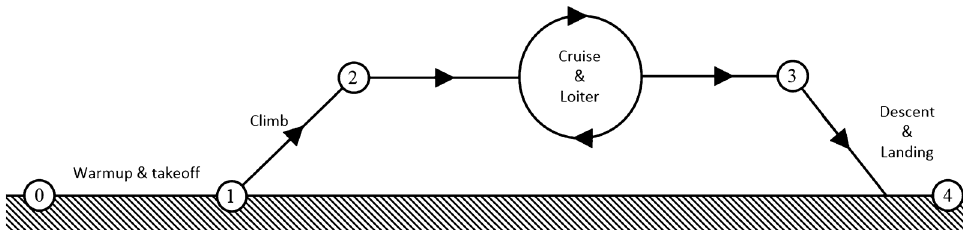
Figure 3. Mission profile of the HCUAV RX-1 [23].